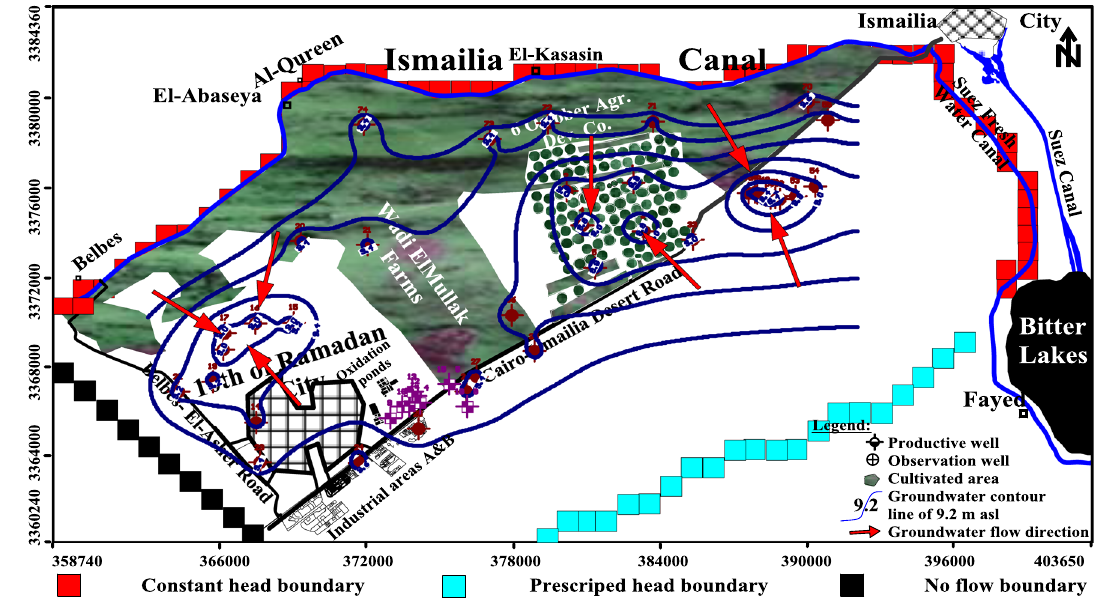
Fig. 10 Predicted head after 30 years of the simulation in Quaternary